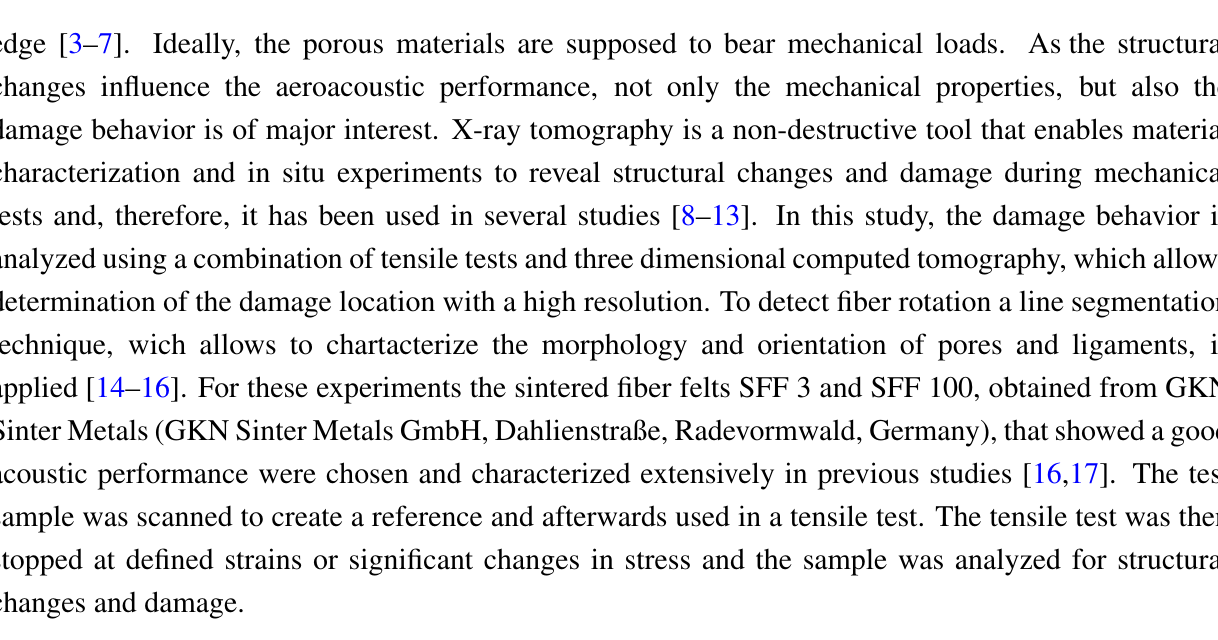
Table 1. Material properties of sintered fiber felts (SFF), including porosity ( φ ), thickness of functional layer ( d ), fiber diameter of functional layers ( D i